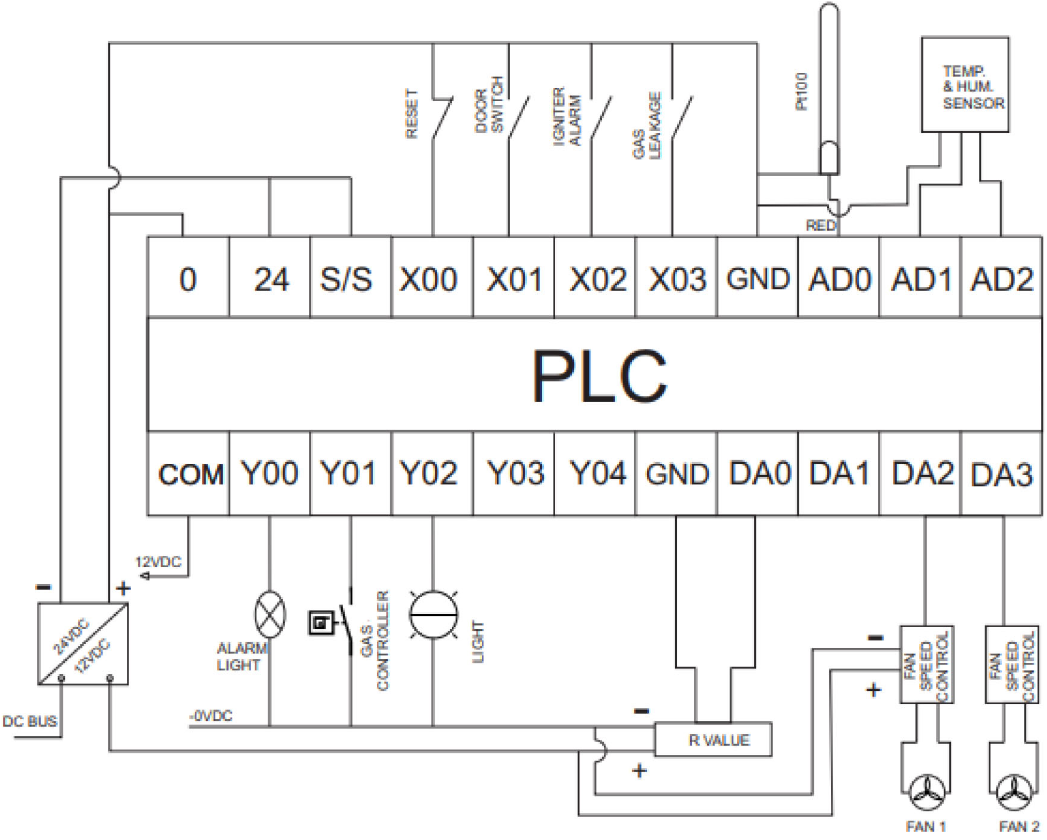
Figure 7. PLC wiring